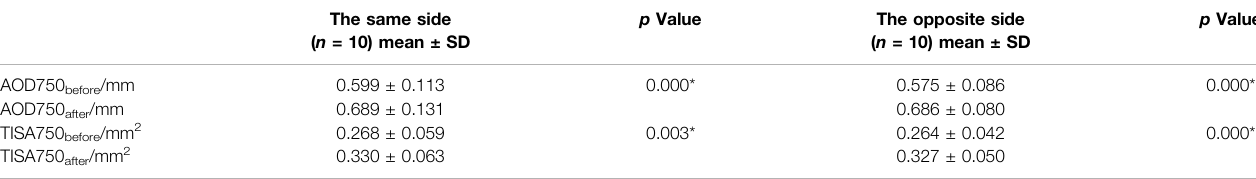
p Value The opposite side